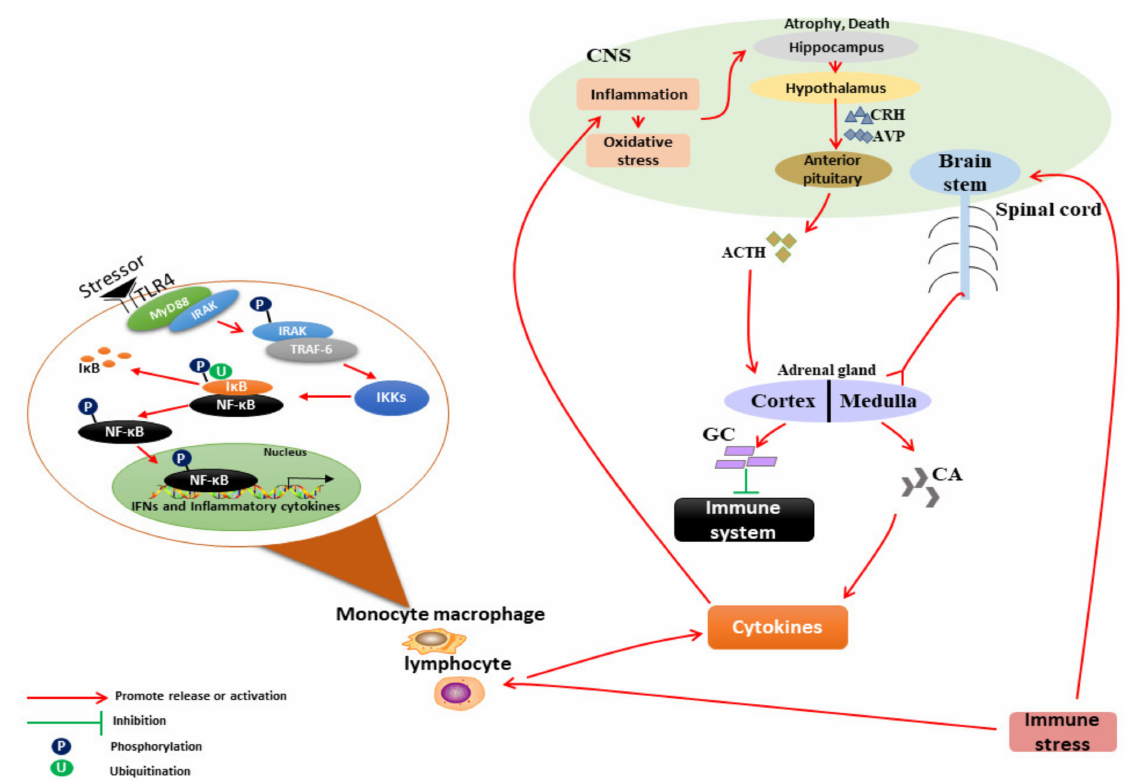
Figure 1. Mechanism of IS on the neuro–endocrine–immune